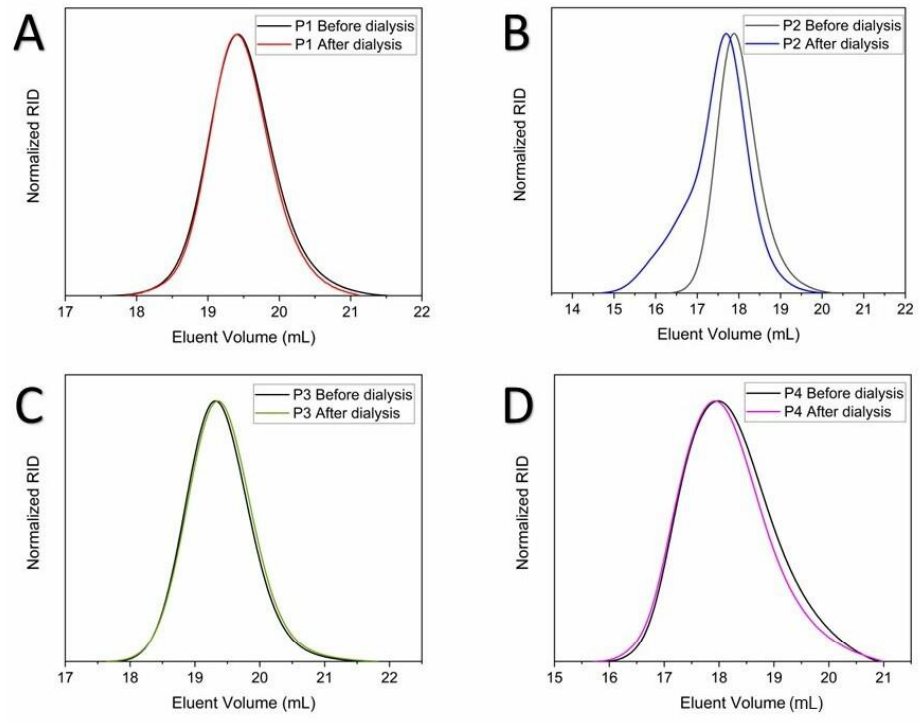
Figure 4. SEC traces of polymers P1-P4. ( A – C ) SEC eluent: DMAc + 0.21 wt. % LiCl, RI detection, calibrated against PMMA standards. ( D ) SEC aqueous eluent: 0.1 M NaNO 3 /0.05% NaN 3 , RI detection, calibrated against PEG standards.